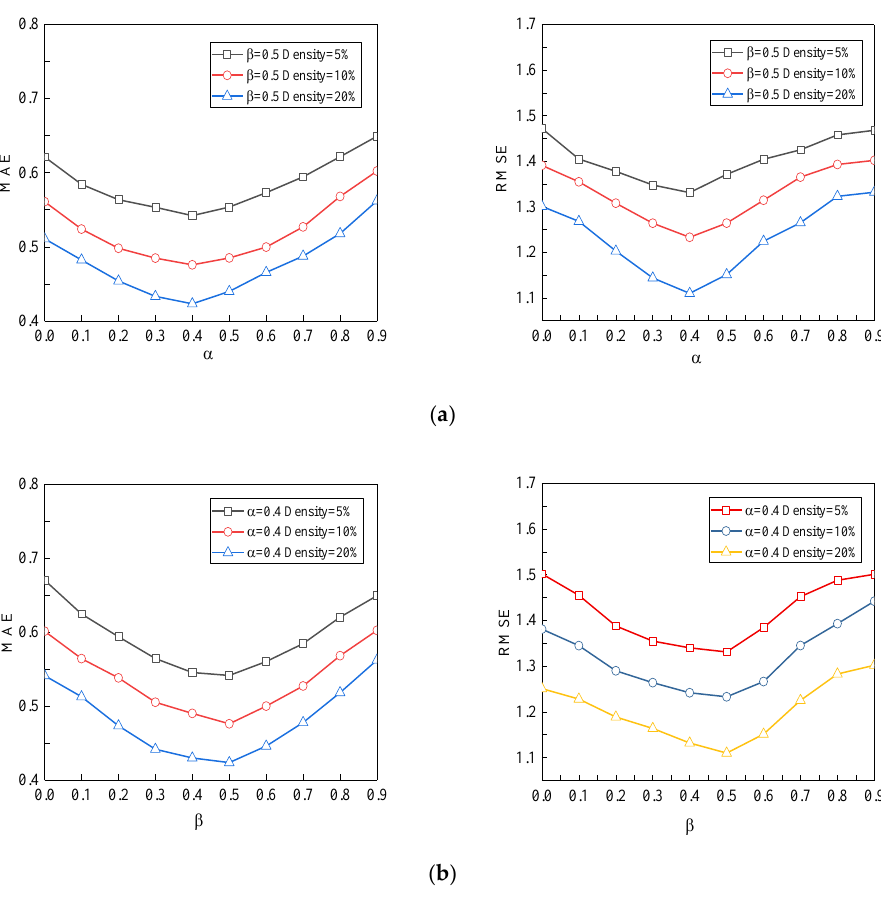
Figure 7. Effect results of  , j i  and density on service recommendation. (a) Effect of  under Figure 7. E ff ect results of α , j (cid:44) i and density on service recommendation. ( a ) E ff ect of α under di ff erent different matrix densities; (b) Effect of  under different matrix densities. matrix densities; ( b ) E ff ect of β under di ff erent matrix